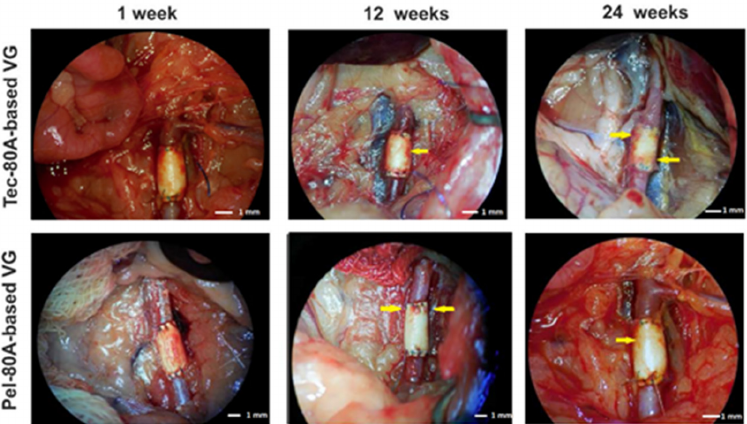
Figure 1. The vascular graft (VG) view during explantation at di ff erent points of observation (Carl Zeiss OPMI Pico surgical microscope). The arrows demonstrate the ingrowth of tissues from the outer VG